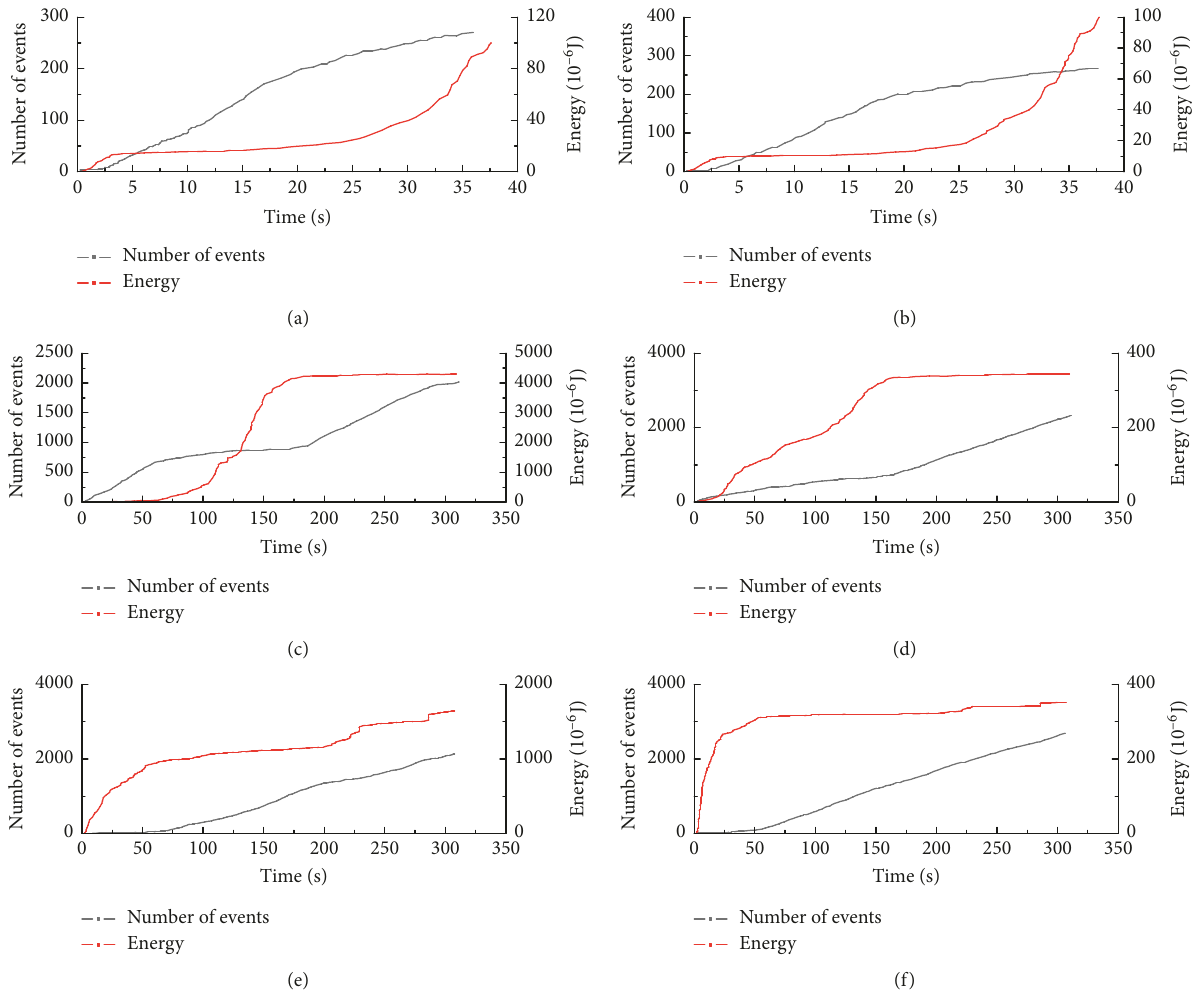
Figure 12: Microseism signal change trend of energy and event numbers at a range of excavation speeds: (a) microseismic sensor 1# at excavation speed v ; (b) microseismic sensor 2# at excavation speed v 1 ; (e) microseismic sensor 1# at excavation speed v sensor 2# at excavation speed v 2